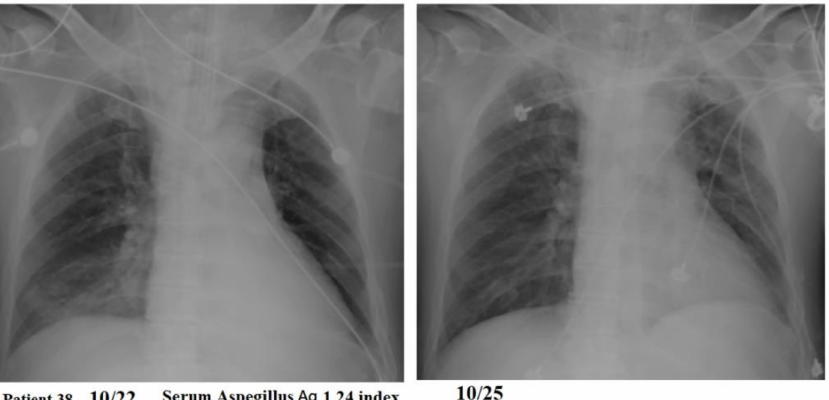
Figure 4. A 48-year-old man had a serum Aspergillus galactomannan test of 1.24 index and did not receive any antifungal therapy but experienced a rapid course of resolution of the pulmonary infiltrates over the right lower lung